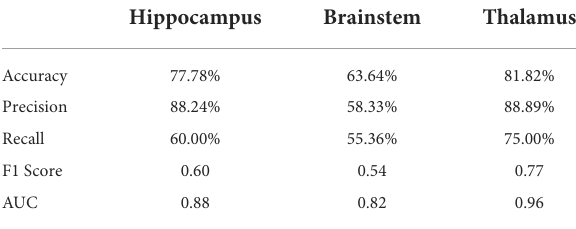
TABLE 1 RAP and selected radiomics features. TABLE 2 Performance of models based on textural features and morphological